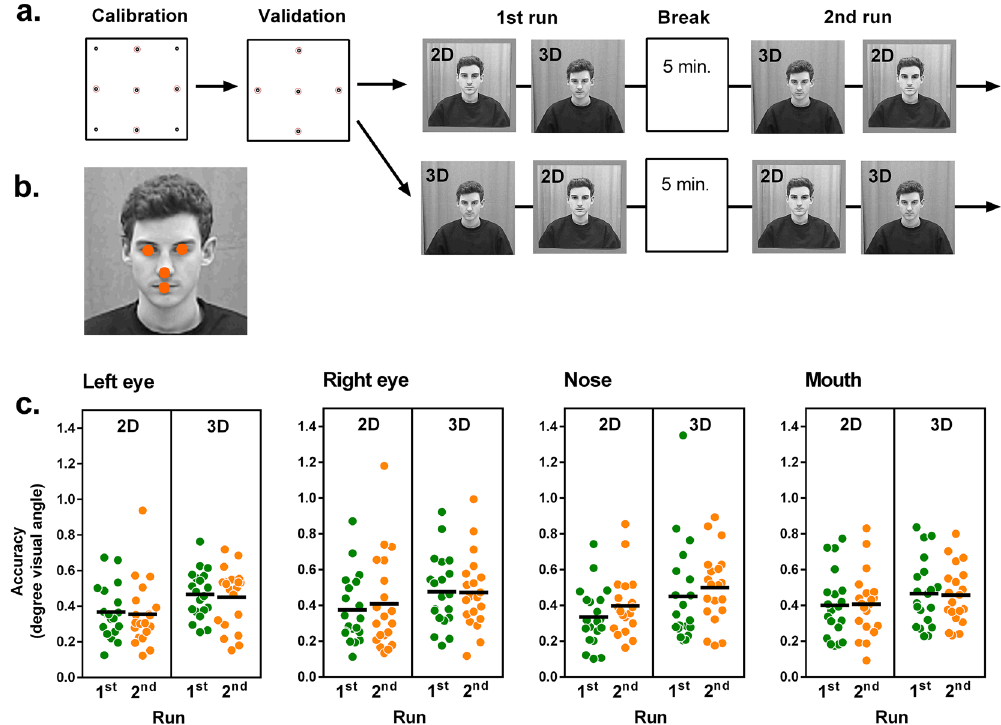
Figure 3. Accuracy for a 2D and a 3D stimulus. ( a ) In a cross-over design half of the sample started with 2D stimulus. During the 5 min break participants stood up and left the room. ( b ) Participants were instructed to fixate on the eyes, nose, and mouth. ( c ) Accuracy for the different facial landmarks in degrees visual angle. Black lines represent mean values. Lower values represent better